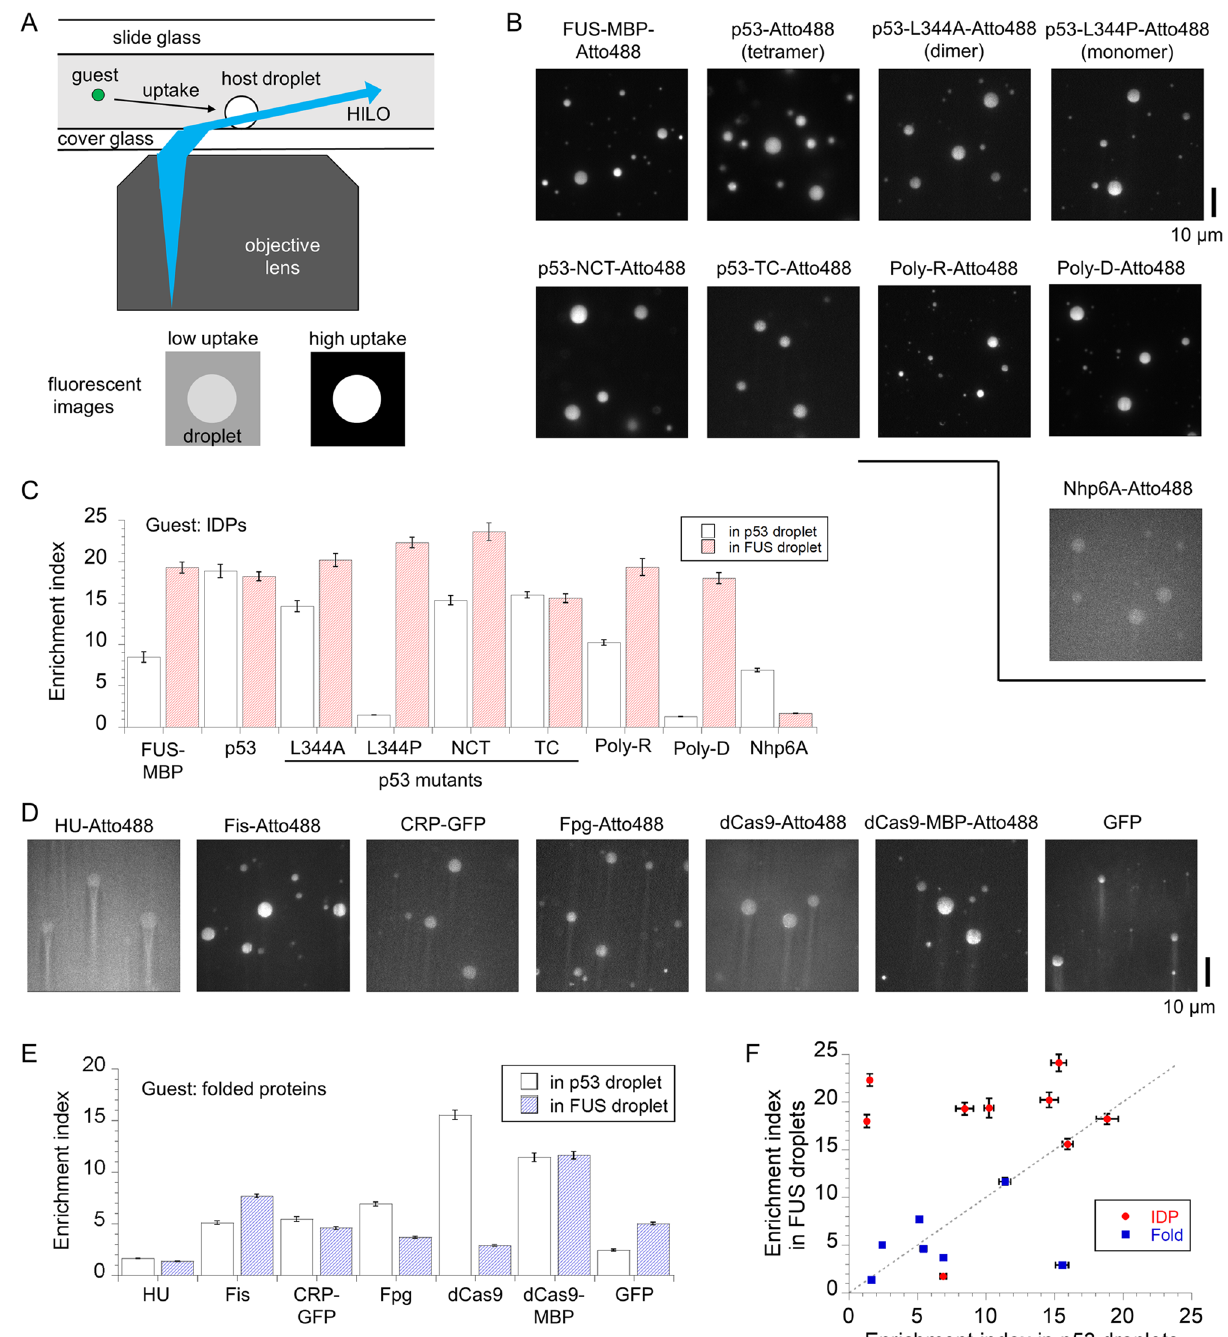
Figure 1. Recruitment property of guest proteins in liquid FUS droplets and comparison with that in liquid p53 droplets. ( A ) Schematic diagram of fluorescent microscopic measurements with highly inclined and laminated optical sheet (HILO) illumination for labeled guest proteins in non-labeled host FUS droplets. Bottom represents schematic fluorescent images of guest uptake. ( B ) Fluorescent images of Atto488-labeled intrinsically disordered proteins (IDPs) and artificial polymers in non-labeled FUS droplet solution. ( C ) Enrichment index (EI) of the guest IDPs and artificial polymers into FUS or p53 droplets. ( D ) Fluorescent images of labeled folded proteins, CRP-GFP, and GFP in non-labeled FUS droplet solution. ( E ) EI of the guest folded proteins into FUS or p53 droplets. ( F ) Comparison of EI in between p53 and FUS droplets. The grey dashed line (EI FUS = EI p53 ) is displayed as a guide for eye. The EI values in p53 droplets were plotted from the Ref. 13 . In panels ( C ), ( E ), and ( F ), bars and errors represent the mean and standard errors for the average EIs of each droplet,